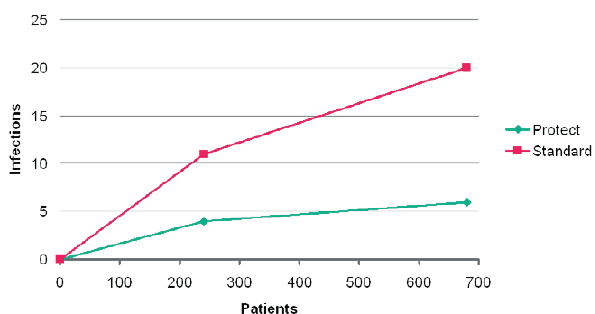
Fig. 1. Flowchart of patient recruitment (in number of patients) and population